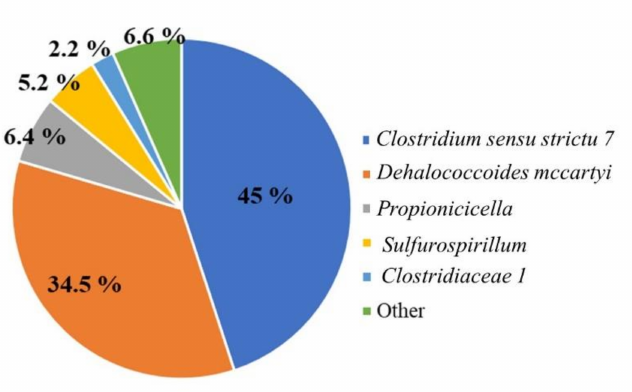
Figure 2. The 16S rRNA gene amplicon sequencing of the dechlorinating inoculum.